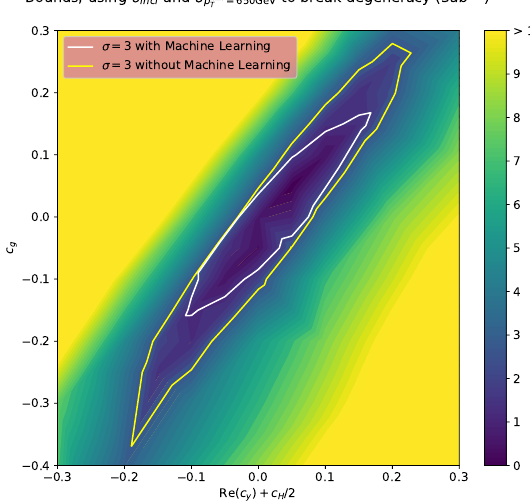
Figure 12 . Expected constraints on the couplings c g , c y and c H derived with and without ML. A signi(cid:12)cant improvement along the anticorrelated direction of c g and using